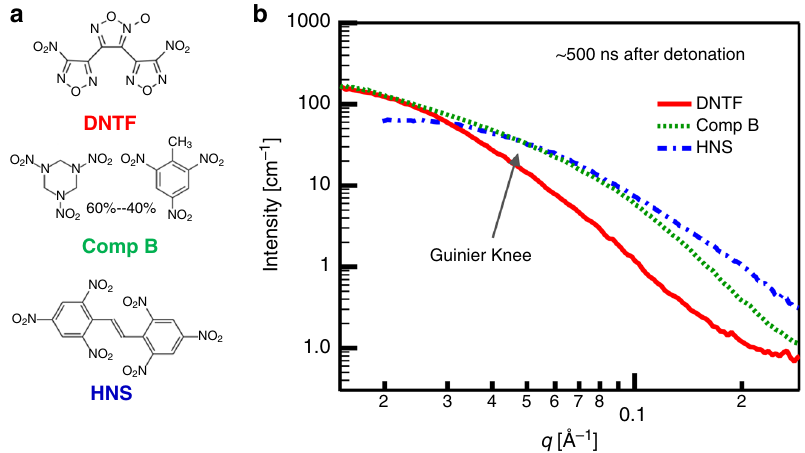
Fig. 3 HE molecules and TR-SAXS data. a Molecular structures for three HE materials measured by TR-SAXS. b TR-SAXS pro fi les, acquired about 500 ns after detonation, for the three explosives exhibit dramatic variation associated with different nanocarbon products. In particular, the Guinier knee is associated with the size distribution of products; for DNTF (red solid line), the larger size distribution of nano-onions (average diameter ~10 nm) manifests in a Guinier knee at much lower q compared to HNS (blue dash-dotted line) and Comp B (green dotted line). Data are provided in a Source Data fi